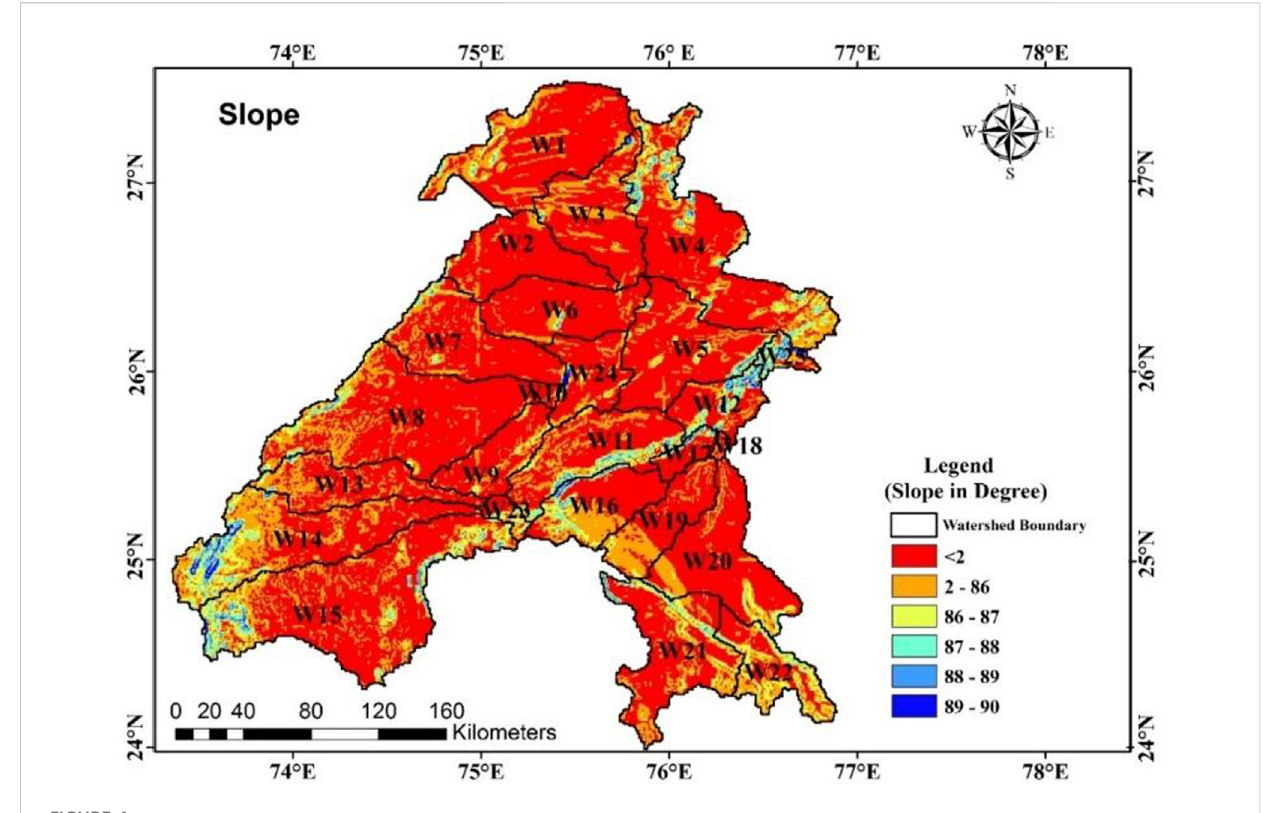
FIGURE 4 Slope map of the study